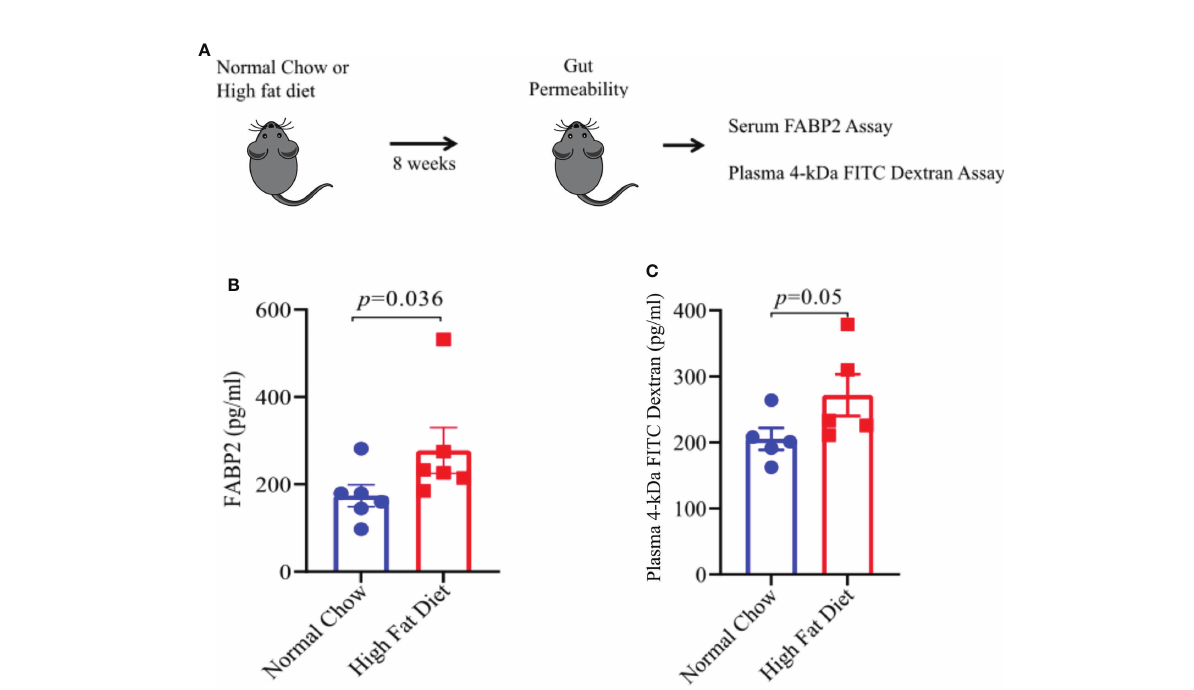
FIGURE 5 A High Fat Diet results in increase gut permeability. (A) Schematic of experimental design. 6-8-week old male mice were placed on the indicated diet for 8 weeks prior to FITC-dextran permeability assay and FABP2 assay. For FITC-dextran permeability assay, mice on either diet were fasted for 6 hours prior to oral treatment with 4 kDa FITC-dextran. Serum samples were taken 2 hours post-treatment. Sera level of FITC was measured, using a spectrophotometer, as a measurement of intestinal permeability. For FABP2 assay, blood sera samples were analyzed by ELISA as per manufacturer protocol. (B) FABP2 concentrations in HFD and Normal chow mice. (C) 4 kDa FITC-dextran level in HFD and Normal chow mice. Error bars represent the standard error of the mean for each experimental group. p- value was determined by Mann-Whitney test between the experimental groups in (B, C)